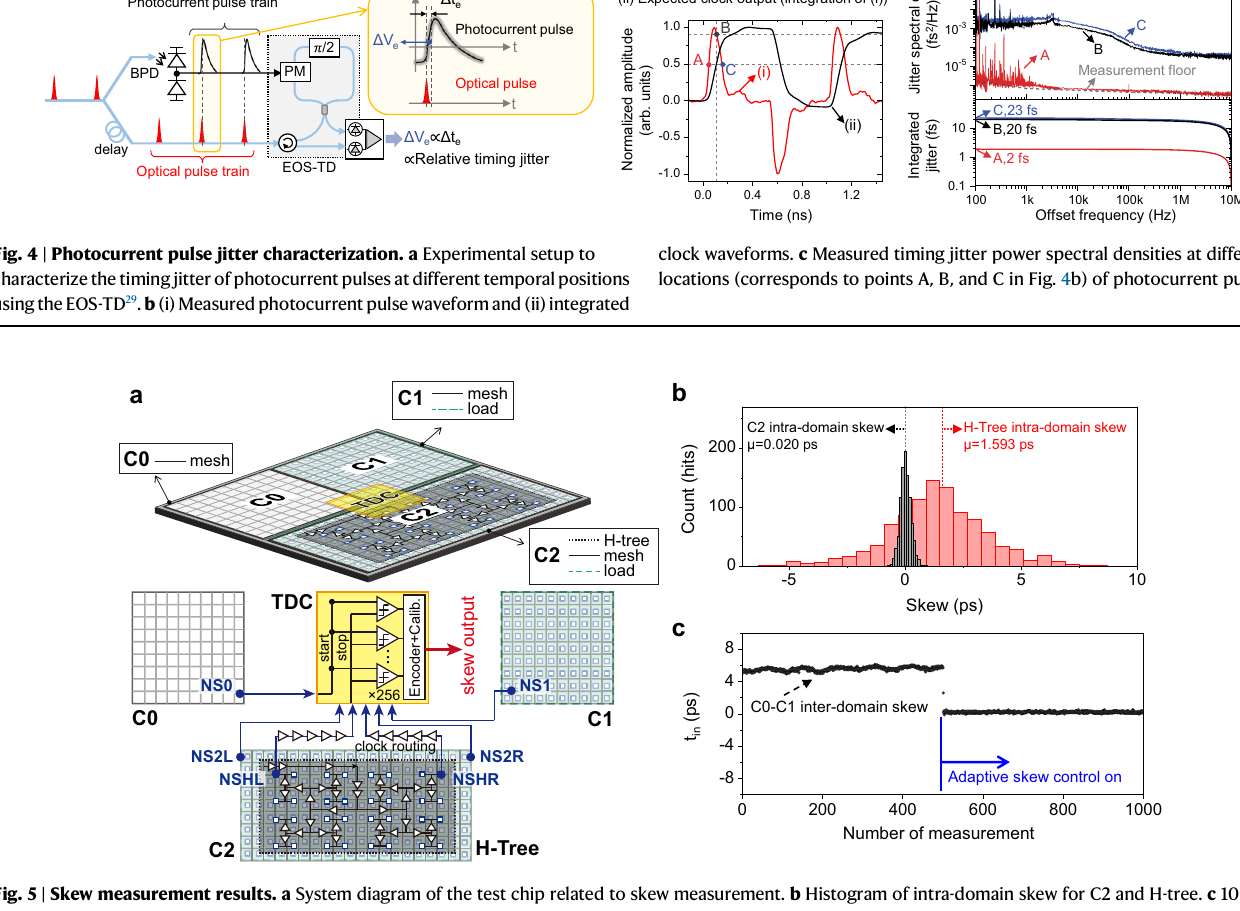
Fig. 5 | Skew measurement results. a System diagram of the test chip related to skew measurement. b Histogram of intra-domain skew for C2 and H-tree. c 1000- consecutive measured inter-domain skew between C0 and C1. Slowly-varying inter-domain skew offset of C1 is compensated by adaptive skew